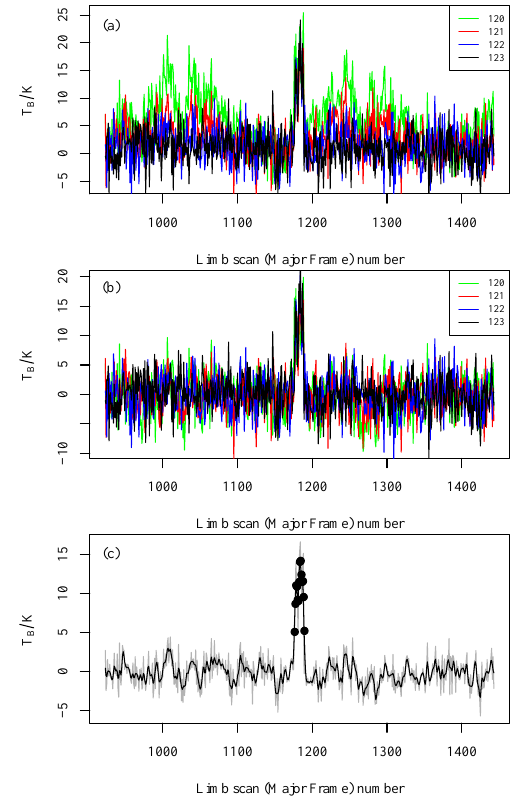
Fig. 2. (a) Mean spectra for 13 limb scans between 18 ◦ N and 36 ◦ N and at longitudes around 90 ◦ W on 10 December 2006: a region where the radiances are enhanced following a shuttle launch. (b) As (a) , but one orbit later, so the latitudes are the same, but the longitudes are 25 ◦ further west. Radiances here are typical for this latitude and season. (Radiances are again presented as Rayleigh- Jeans brightness temperature T B in K.)